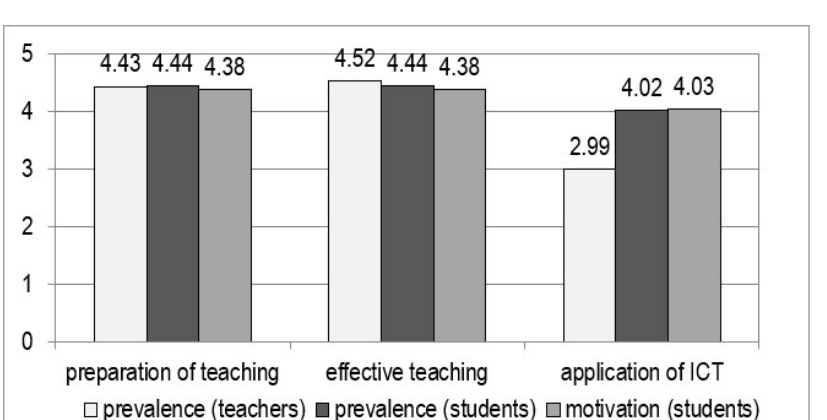
Figure 1. Characteristics of the teaching process from the perspective of teachers and